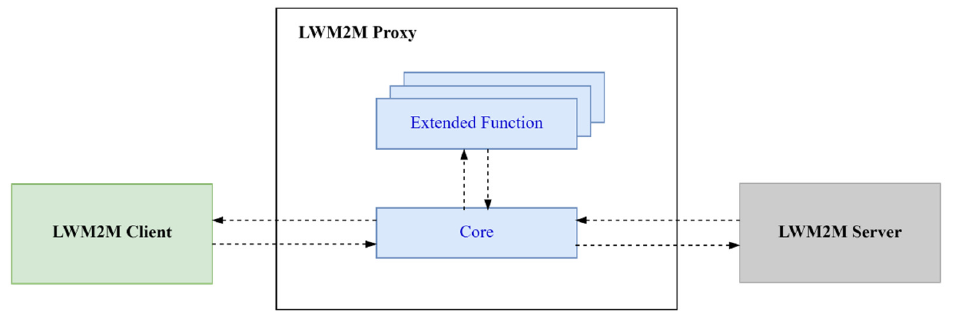
Figure 3. Architecture of the LWM2M Proxy and its relationship with other LWM2M components.